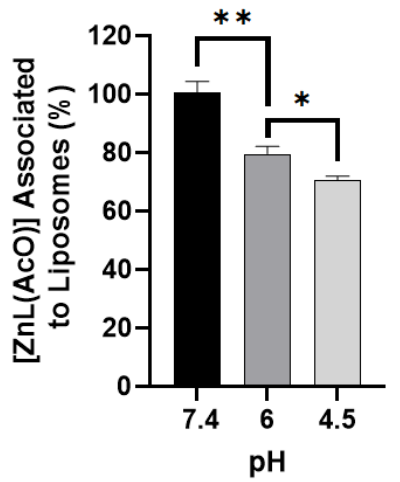
Figure 3. Stability of [ZnL(AcO)]-loaded nanoliposomes: influence of pH conditions. [ZnL(AcO)] nanoformulation F4 was incubated in HEPES buffer at pH 4.5, 6.0, or 7.4 for 90 min at 37 °C under stirring. The stability was determined as a percentage between the [ZnL(AcO)]-to-lipid ratio after incubation at pH 4.5, 6.0, or 7.4 and the [ZnL(AcO)]-to-lipid ratio before incubation at pH 7.4. Data are expressed as means ± SD of two independent experiments (** p < 0.01 vs. pH 6, * p < 0.05 vs. pH 4).